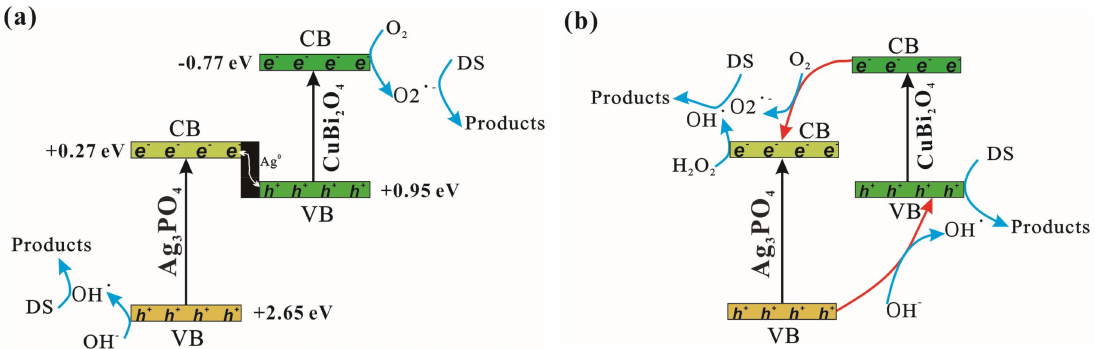
Figure 8. Schematic diagram for E g matching and flow of photoinduced electrons/holes for ( a ) CuBi 2 O 4 /Ag 3 PO 4 -SC; ( b ) CuBi 2 O 4 /Ag 3 PO 4 -SC (H 2 O 2